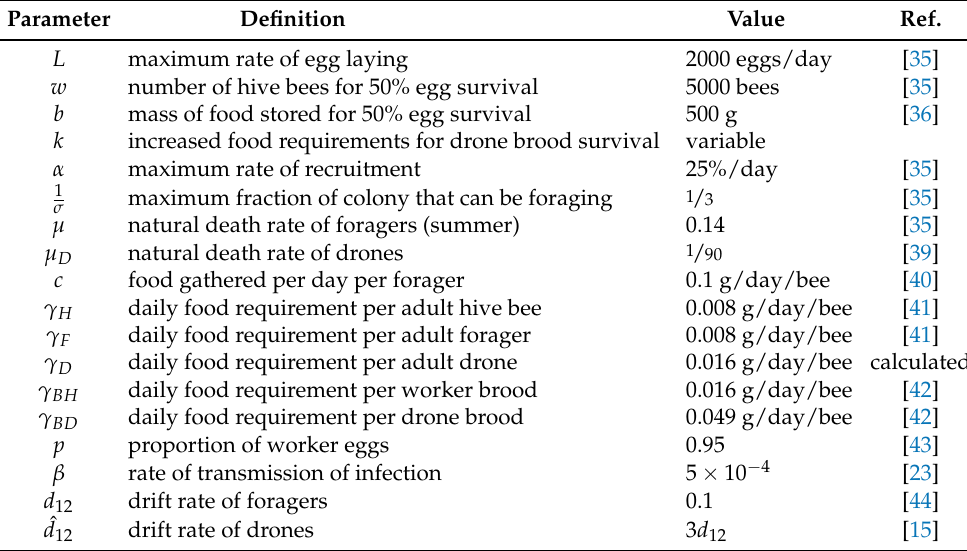
Table 1. Parameter values and source references.